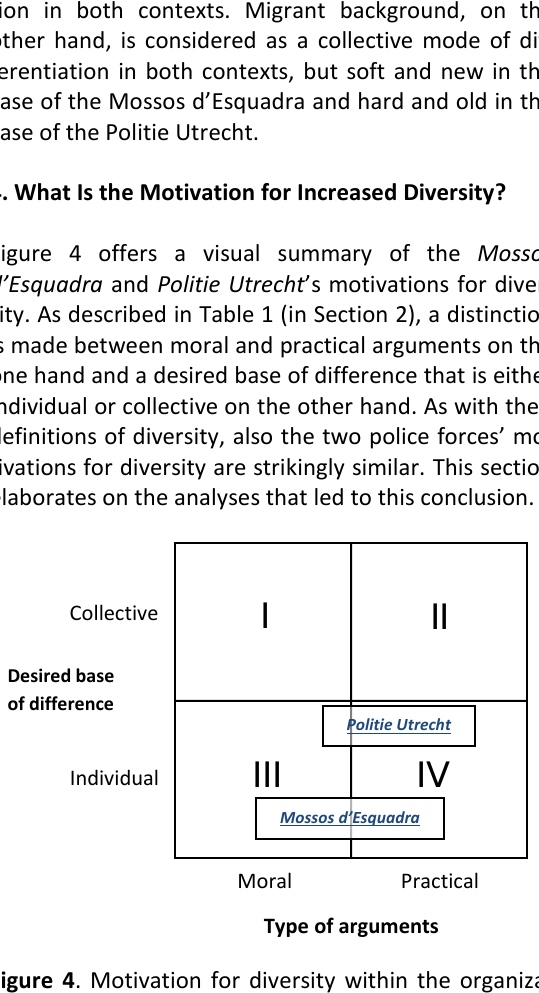
Figure 4 . Motivation for diversity within the organiza- tion (Mossos d’Esquadra, Politie